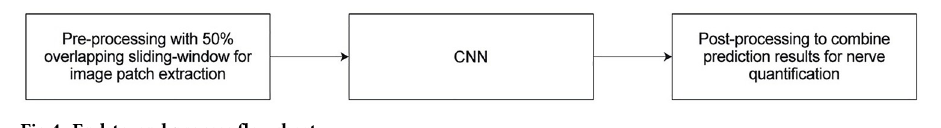
Fig 4. End-to-end process flowchart.